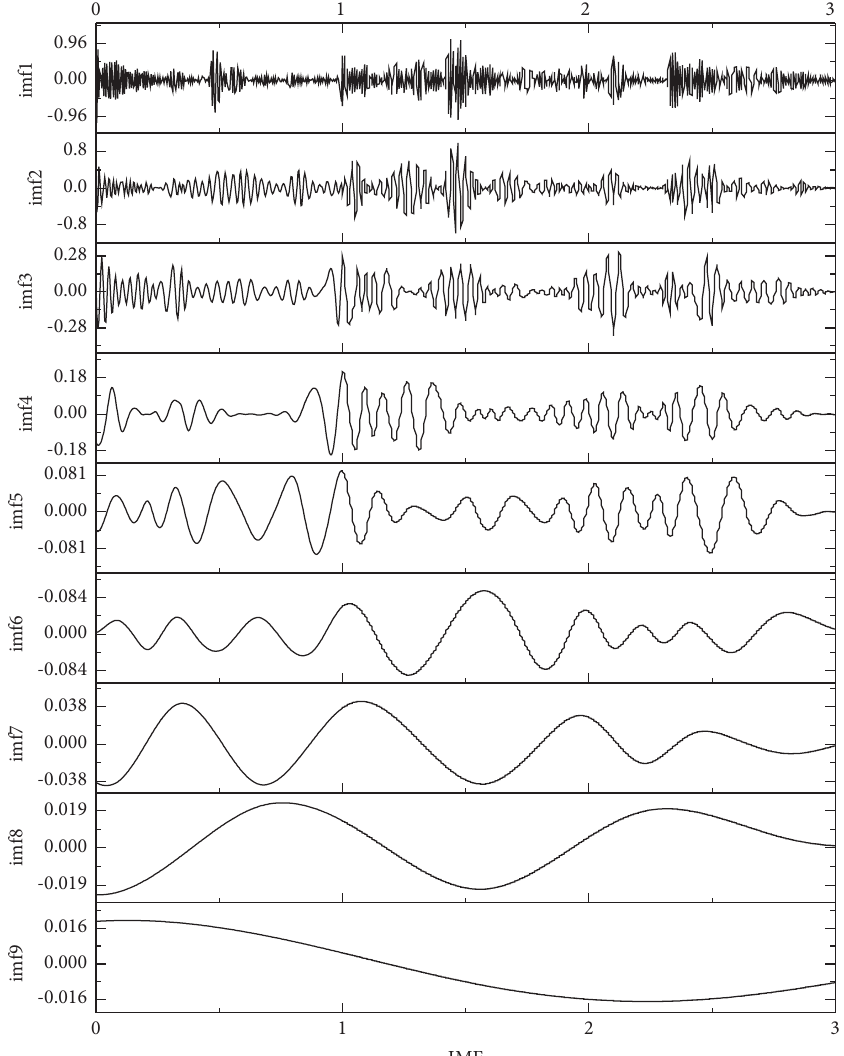
Figure 15: EMD results of vibration signals in coal gangue mixing